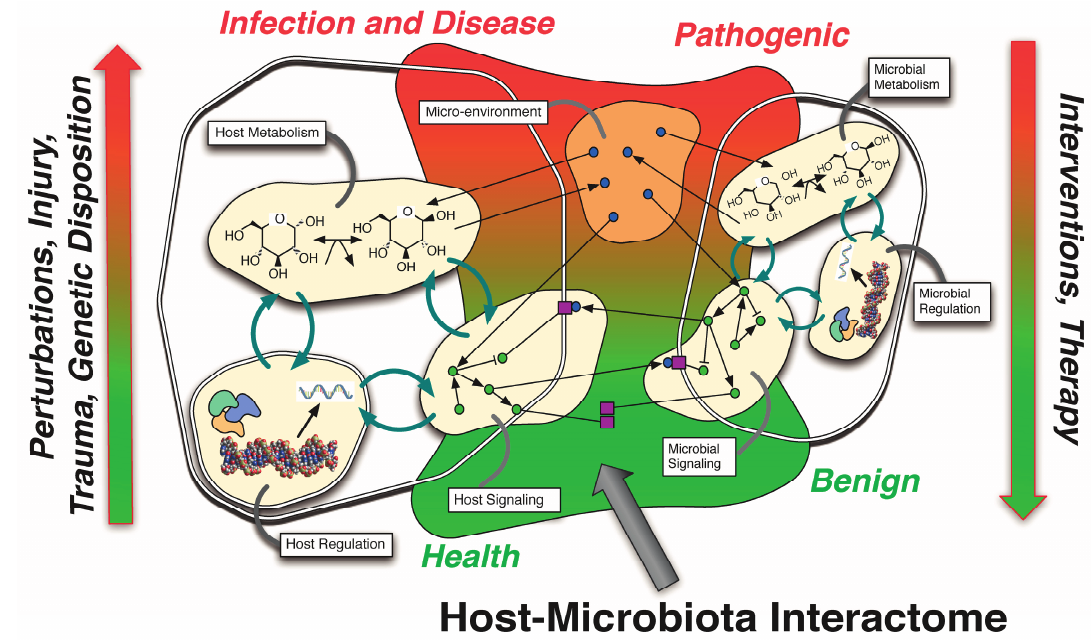
Figure 1. The Host-Microbiota Interactome. The homeostasis of a healthy host and a benign microbiota can shift towards infection and disease in the host and a pathogenic microbiota due to many factors such as injury, trauma and genetic disposition, while interventions and therapy can shift it back. In actuality, there is a spectrum of physiological states, perturbations and interventions between those two extremes as abstractly represented by the color gradient. The host-microbiota interactome consists of multiple inter-connected components. Metabolic, signaling and regulatory components are shown as tightly-coupled processes within host and microbial cells. Extracellular metabolite exchange and competition occurs in the micro-environment shared by host and microbial cells, and these metabolites can directly affect metabolism and signaling processes. Signaling pathways within host and microbial cells secrete molecules into the extracellular environment, sense the local environment by processing extracellular molecules that bind to cell receptors, and mediate physical interactions between